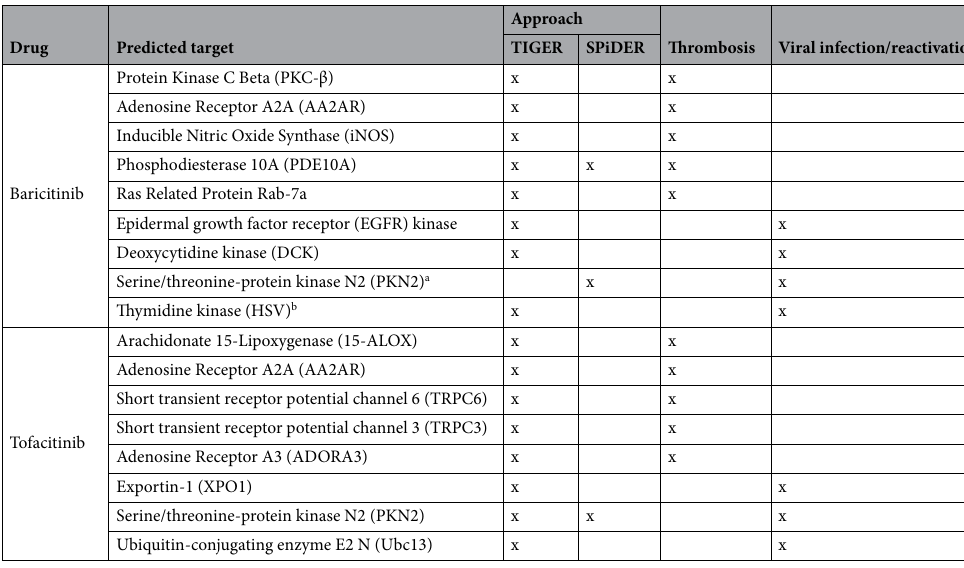
Table 1. Suggested targets with impact on thrombosis and viral infection per JAK inhibitor drug and target prediction approach. Commercial assays were unavailable for TRPC6 or TRPC3, and therefore, these targets could not be validated. Instead, transient receptor potential cation channel subfamily M member 6 (TRPM6) was employed for the respective binding assays. a PKN2 was included in the list of targets tested for baricitinib, which allowed us to make a direct comparison between tofacitinib and baricitinib inhibitory activity on this target. b Human herpesvirus 1 (strain SC16).